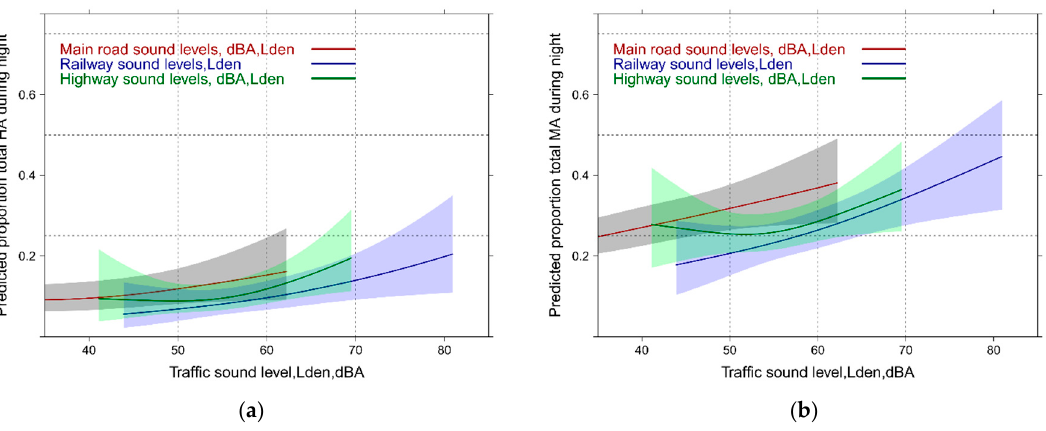
Figure 11. Predicted proportion of nighttime total annoyance associated with sound source level. ( a ) HA = Proportion highly annoyed; ( b ) MA = Proportion moderately annoyed. Adjusted for age, sex, education, noise sensitivity, health status and the other sound sources.